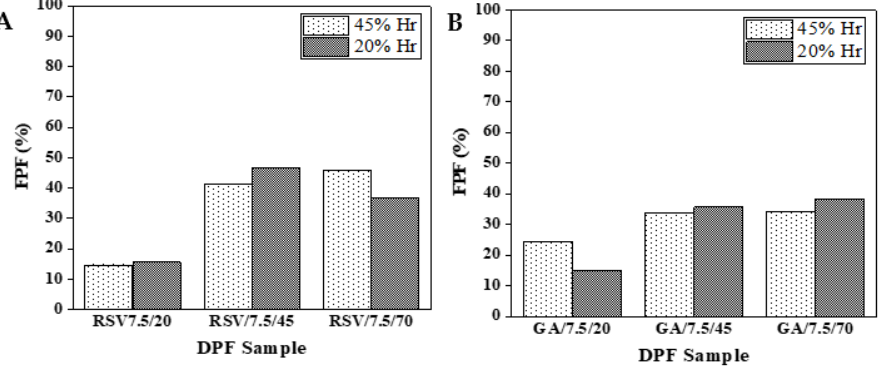
Figure 9. Fine particle fraction (FPF) for 7.5 % w / v DPFs stored at different %RH, varying ethanol volume from 20 to 70 % v / v : ( A ) RSV – DPF; ( B ) GA – DPF.